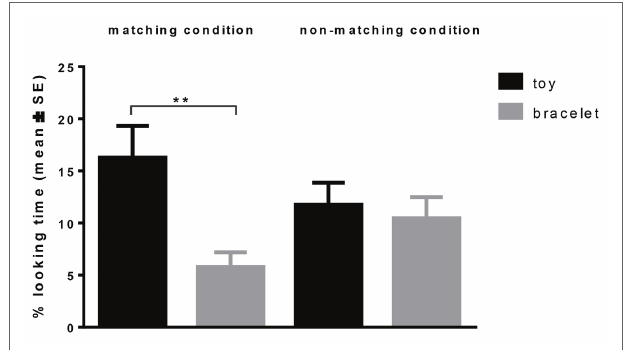
FIGURE 2 | Duration of looking time (in percent) at the toy and the bracelet in the matching (owner reacts happy toward toy, with disgust toward bracelet) and non-matching (owner reacts happy toward bracelet, with disgust toward toy) condition in Study 2. Significant differences are indicated ( ** p <